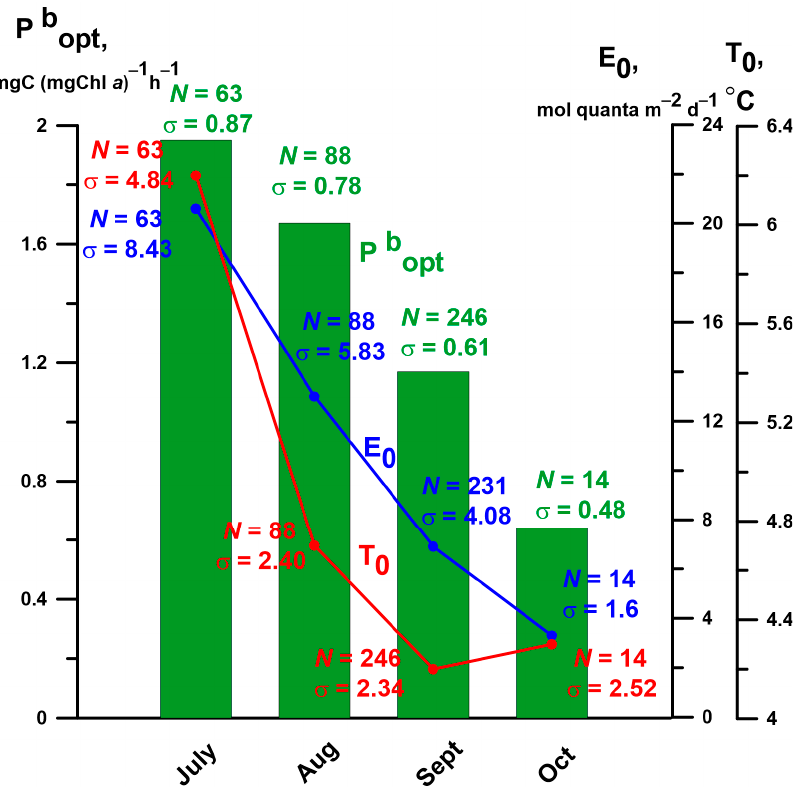
Figure 2. Seasonal variation in the optimal assimilation number and associated environmental factors in the Siberian Seas. Bars are the average values of the optimal assimilation number (P bopt ). The blue line is subsurface PAR (E 0 ). The red line is sea surface temperature (T 0 ). The vertical line segments indicate standard deviation. Table 4. The correlation matrix between the log-transformed optimal assimilation numbers for dif-